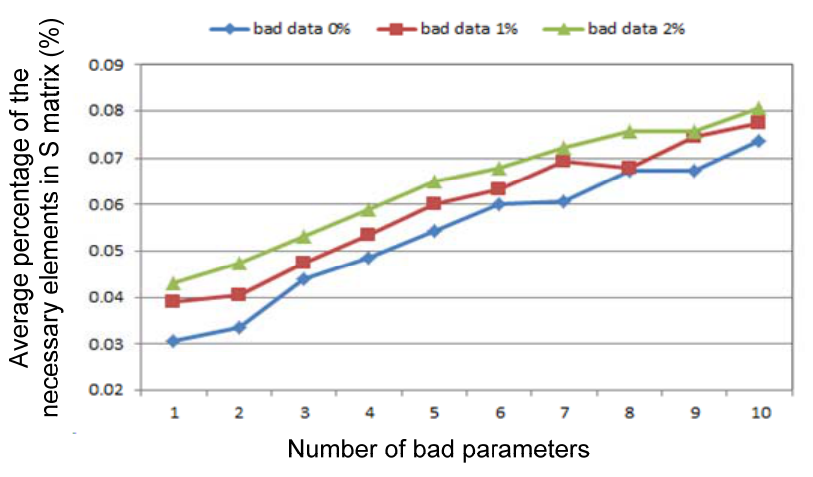
Figure 3. Average necessary element rates in the S matrix.